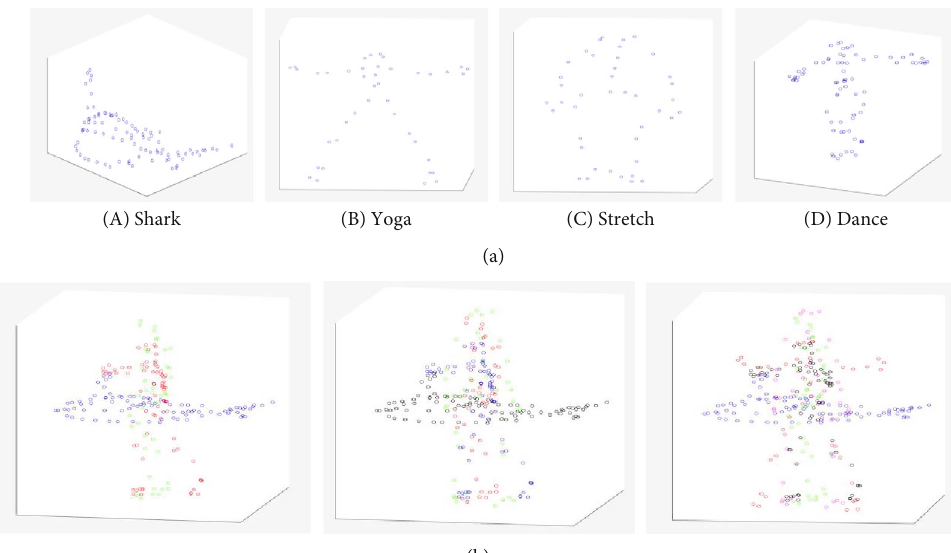
Figure 2: (a) Visualisation of some NRSFM datasets. (b) Example of synthetic datasets reference in [15, 16]. Di ff erent colors represent di ff erent motion.